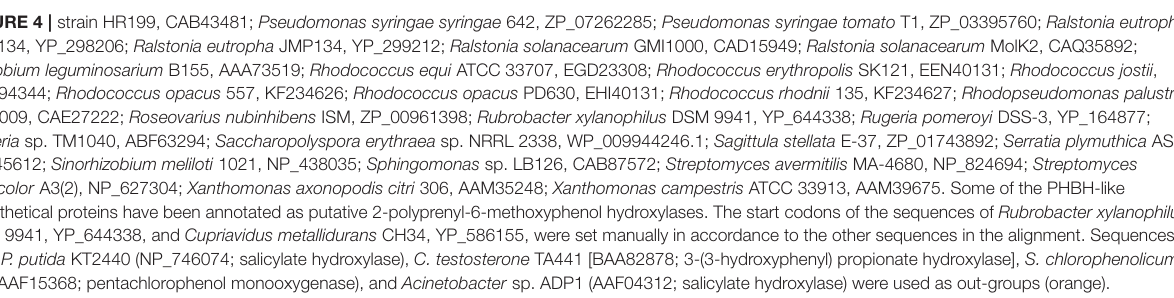
FIGURE 4 | strain HR199, CAB43481; Pseudomonas syringae syringae 642, ZP_07262285; Pseudomonas syringae tomato T1, ZP_03395760; Ralstonia eutropha JMP134, YP_298206; Ralstonia eutropha JMP134, YP_299212; Ralstonia solanacearum GMI1000, CAD15949; Ralstonia solanacearum MolK2, CAQ35892; Rhizobium leguminosarium B155, AAA73519; Rhodococcus equi ATCC 33707, EGD23308; Rhodococcus erythropolis SK121, EEN40131; Rhodococcus jostii , ABG94344; Rhodococcus opacus 557, KF234626; Rhodococcus opacus PD630, EHI40131; Rhodococcus rhodnii 135, KF234627; Rhodopseudomonas palustris CGA009, CAE27222; Roseovarius nubinhibens ISM, ZP_00961398; Rubrobacter xylanophilus DSM 9941, YP_644338; Rugeria pomeroyi DSS-3, YP_164877; Rugeria sp. TM1040, ABF63294; Saccharopolyspora erythraea sp. NRRL 2338, WP_009944246.1; Sagittula stellata E-37, ZP_01743892; Serratia plymuthica AS9, AEF45612; Sinorhizobium meliloti 1021, NP_438035; Sphingomonas sp. LB126, CAB87572; Streptomyces avermitilis MA-4680, NP_824694; Streptomyces coelicolor A3(2), NP_627304; Xanthomonas axonopodis citri 306, AAM35248; Xanthomonas campestris ATCC 33913, AAM39675. Some of the PHBH-like